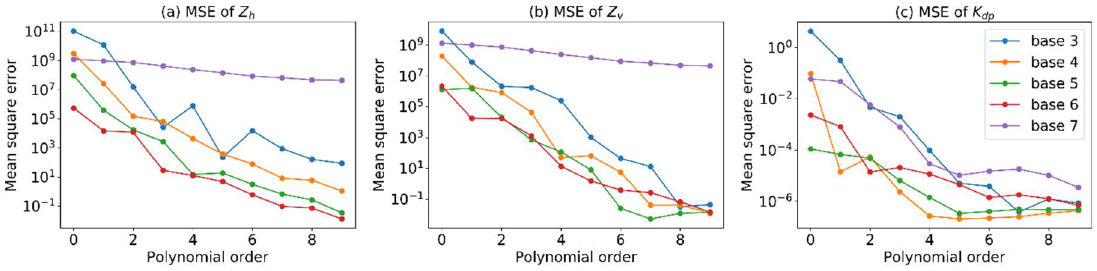
Figure 3. The mean square errors for polynomial fits for the forward operator of: ( a ) Z h ; ( b ) Z v ; and ( c ) K dp . The various colors represent basis orders ranging from 3 to 7.